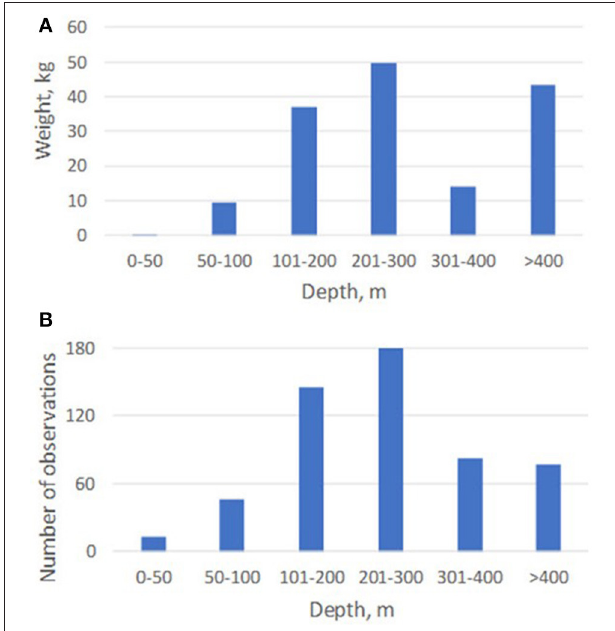
FIGURE 8 | (A) Sailing routes for fisheries (green lines), (B) sailing routes for other than fisheries: oil tankers (brown), chemicals/product tankers (red), bulk ship (orange), general cargo ship (blue), cooling/freezing (magenta), passenger (yellow), other activities (peach). Taken from the website havbase.no, period: August 2016.